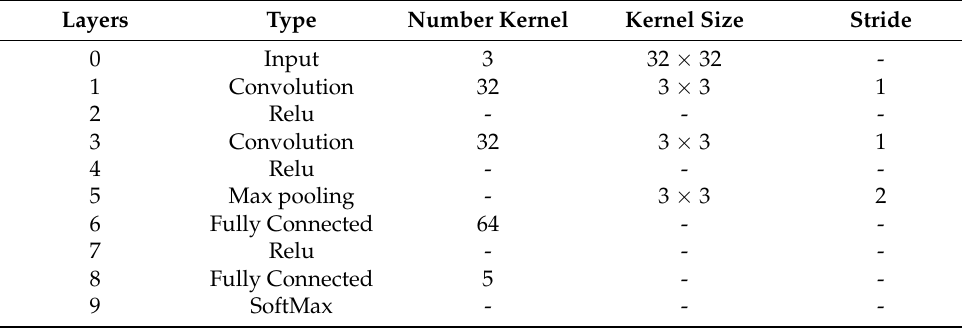
Table 2. Details of the proposed model